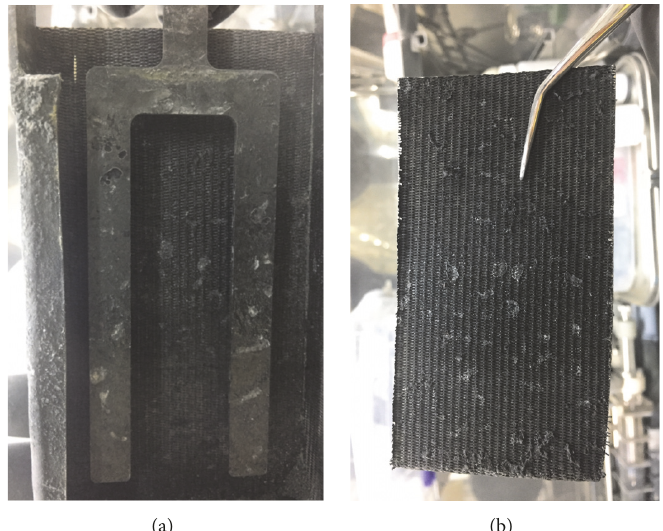
Figure 6: Images of the reused cathode basket after the second OR and the subsequent fuel separation via salt draining: (a) inside view and (b) its inner surface of the STS wire